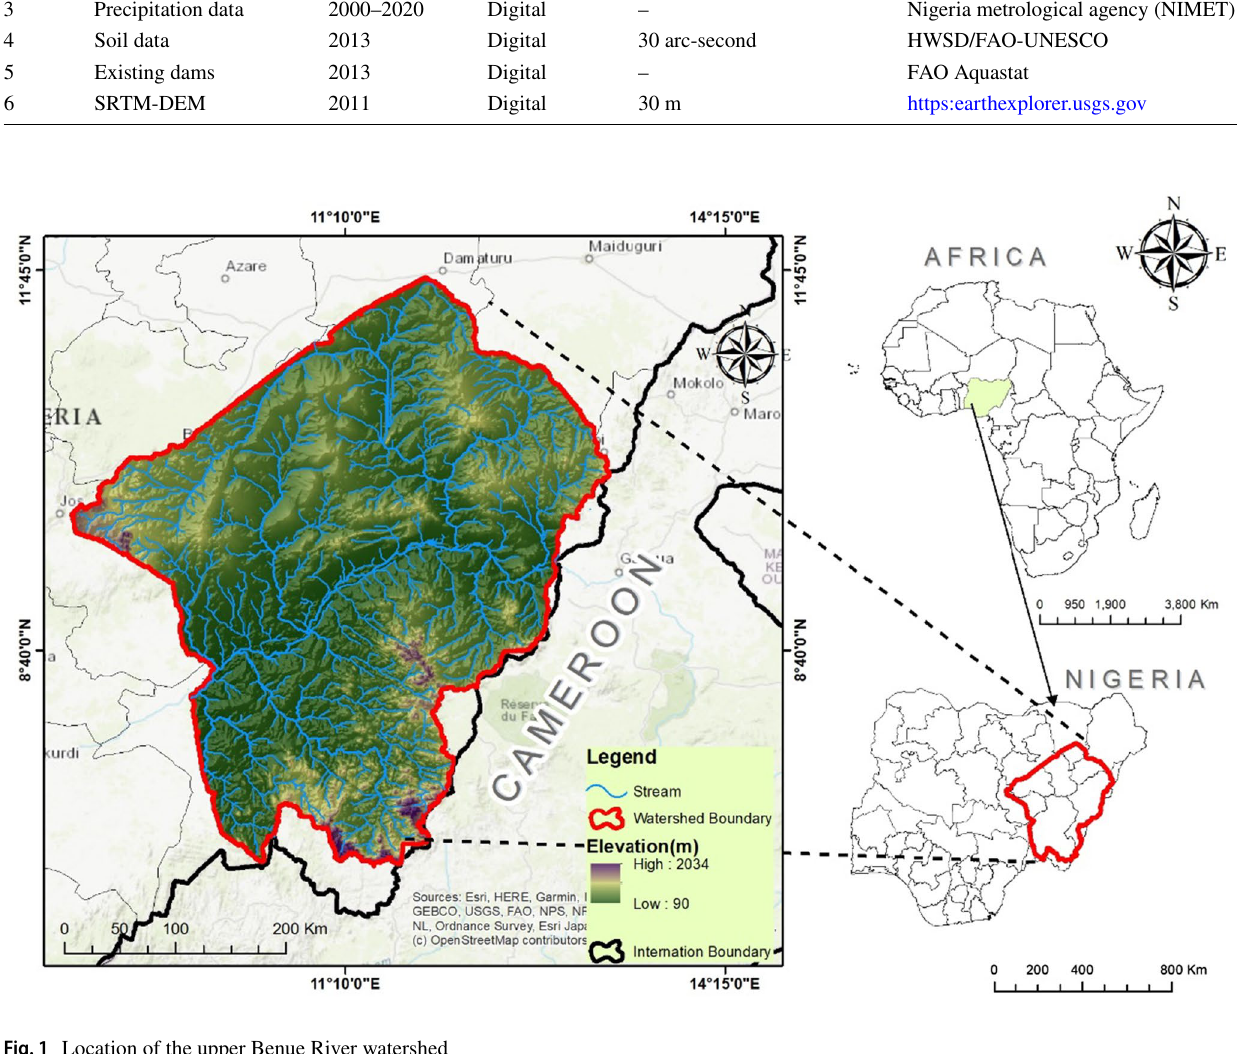
Fig. 1 Location of the upper Benue River